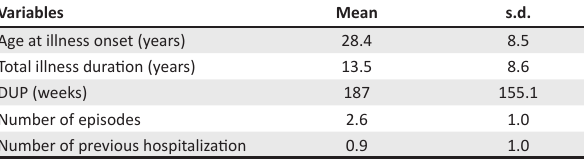
TABLE 2: Clinical profile of the participants. Variables Mean